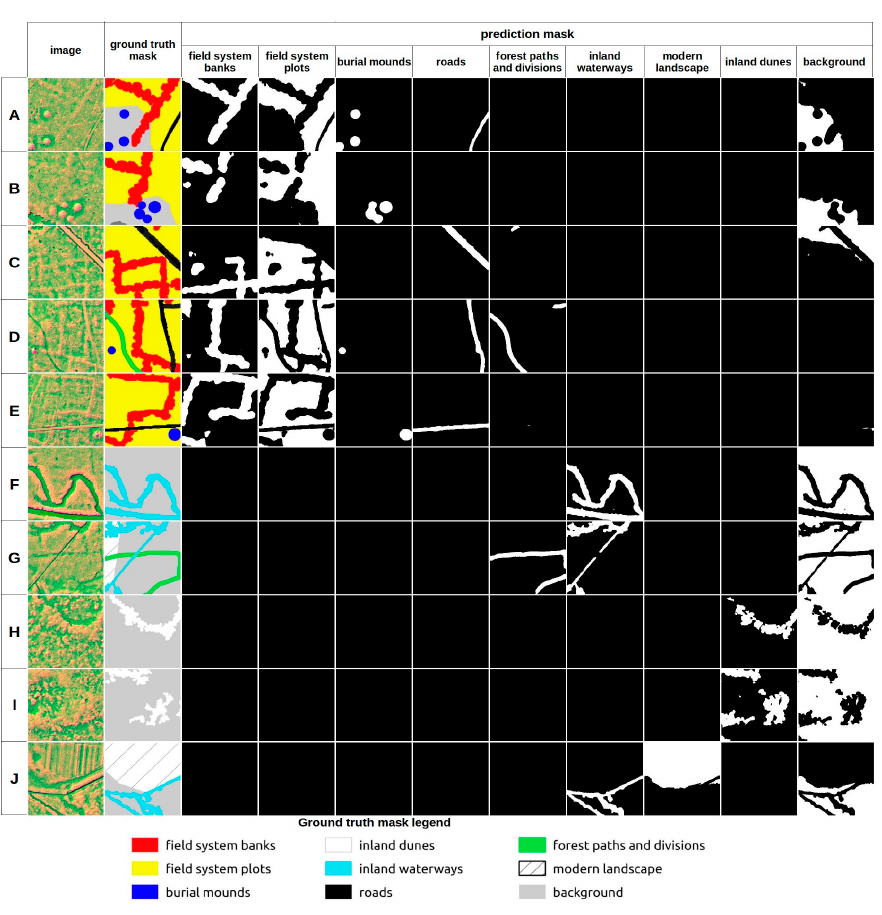
Figure 14. Test set tiles samples ( A – J ), manually drawn ground truth mask and the results of semantic segmentation (prediction masks) of the test area with the U ‐ Net model.